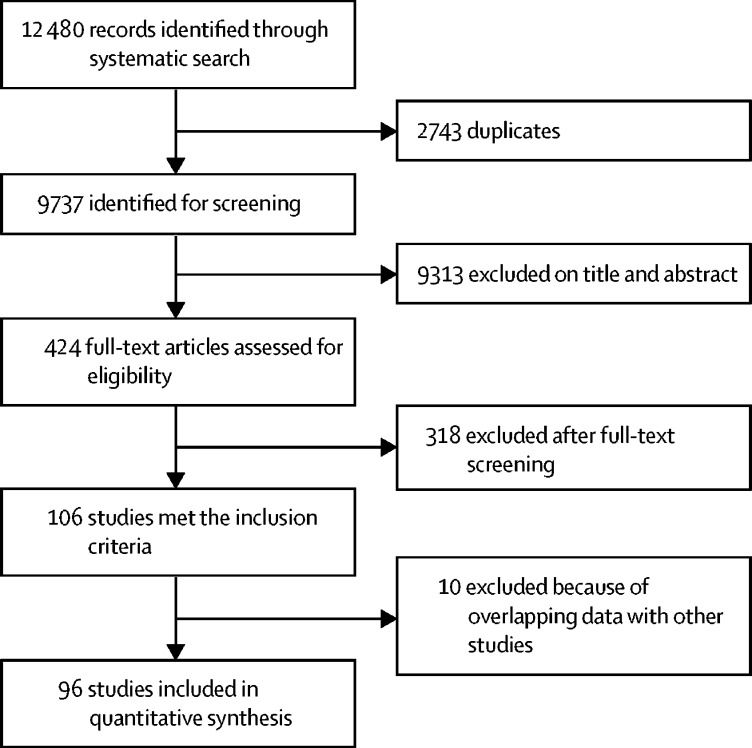
Study selection